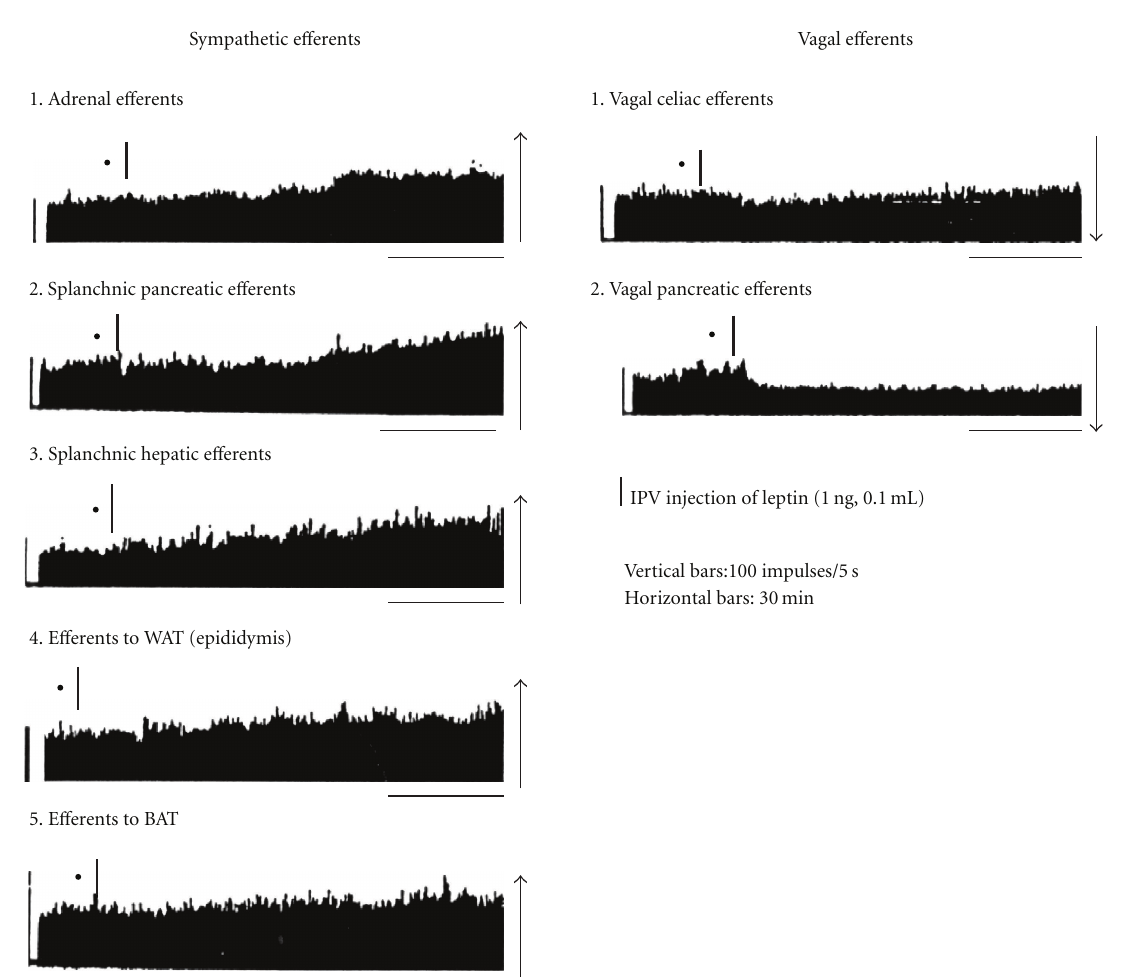
Figure 3: Reflex e ff ects of IPV injection of leptin (1ng, 0.1mL) on e ff erent discharges of sympathetic and vagus nerve. Arrows indicate the time of injection.